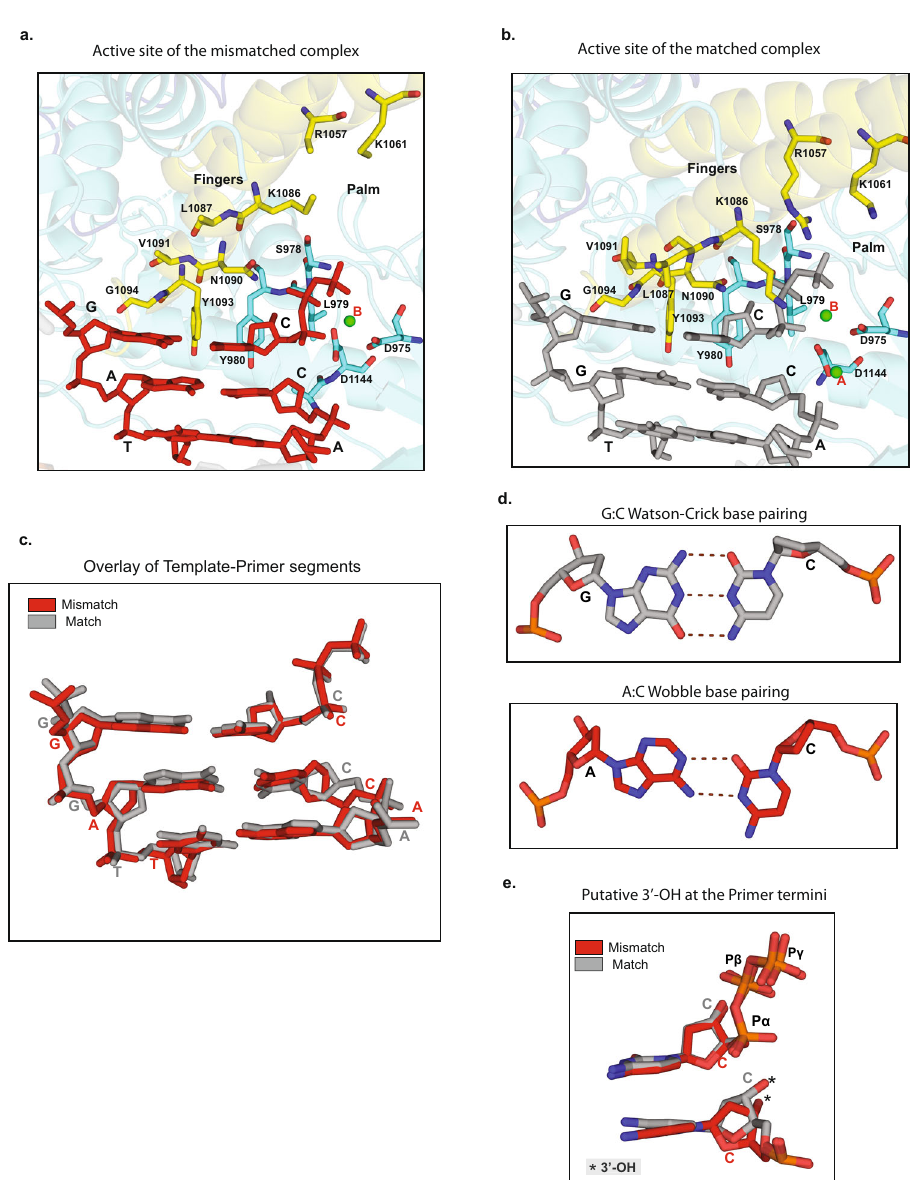
Fig. 2 Active sites of the Pol ζ complexes with mismatched and matched DNA. a Close-up view of the Pol ζ active site in the mismatched DNA complex depicting the key residues from the fi ngers (yellow) and palm (blue) domains in close proximity to the replicative end of the template-primer DNA (red) and incoming dCTP (red). A green sphere depicts metal ion B. b Close-up view of the Pol ζ active site in the matched DNA complex (PDB ID: 6V93). The coloring scheme is the same as in a., except that the template-primer and dCTP are shown in gray. The complete side chains for few residues including Lys 1061 , Lys 1086 , and Arg 1057 have not been built in mismatched DNA complex due to less well-de fi ned cryo-EM density. c Overlay of equivalent template- primer segments and incoming dCTP for the mismatched (red) and matched (gray) DNA complexes. d Base pairing at the primer terminus in the matched (G:C, gray color) and mismatched (A:C, red color) complexes. e Position of putative 3 ’ -OH (marked by a star) at the primer terminus relative to the incoming dCTP in the mismatched (red) and matched (gray)